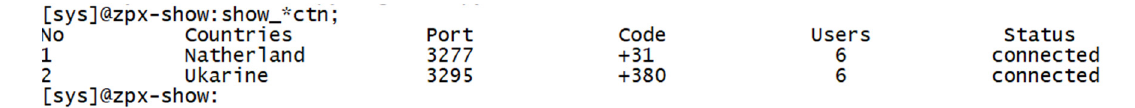
Figure 14. Account Block in case of invalid queries. This article uses Cloud Shell to protect the cloud server from internal attacks. If the attacker gains access to the cloud server but does not know the exact query, the attacker can be easily identified. If a valid user tries to tamper with other users’ data, that user’s account is blocked. If mechanisms were created to secure the cloud server, the attacker devised more attacks than security mechanisms. Cloud Shell is an efficient technique in which every user can be given limited access, and each user will be able to stay within their limits. It will not know other users’ queries, nor will it be able to destroy anyone else’s data. 4.2.2. Prevention Techniques from Internal Attacks There are three ways to protect the cloud server from internal attacks. The first way is to use the cloud shell on the server using the “rwx” mode as used in this paper. The second way is to store the data in an encrypted form. If a user wants to access data, the user can only do so with the decryption key of their data. The advantage is that no user will access another user’s data. The third way is that, if an attacker tries to gain access to the cloud through malicious activity, these activities will be blocked through Cloudflare.